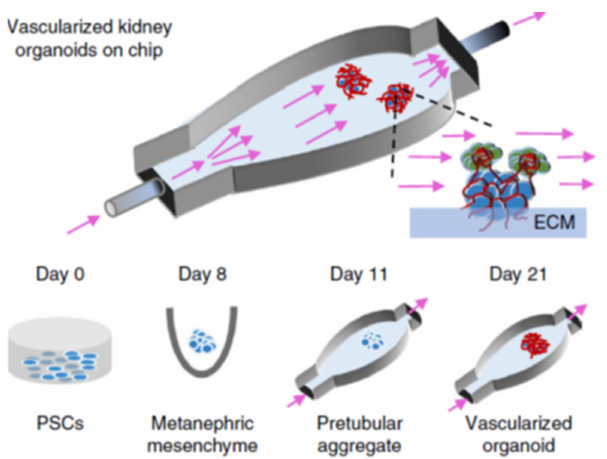
Figure 5. Formation of renal organoids placed on engineered ECM, in a perfusable millifluidic chip, under controlled fluid shear stress. Differentiation days and culture conditions are indicated in the middle and bottom parts of the panel. Organoids not drawn to scale. Reproduced with permission from Nature (adapted from reference